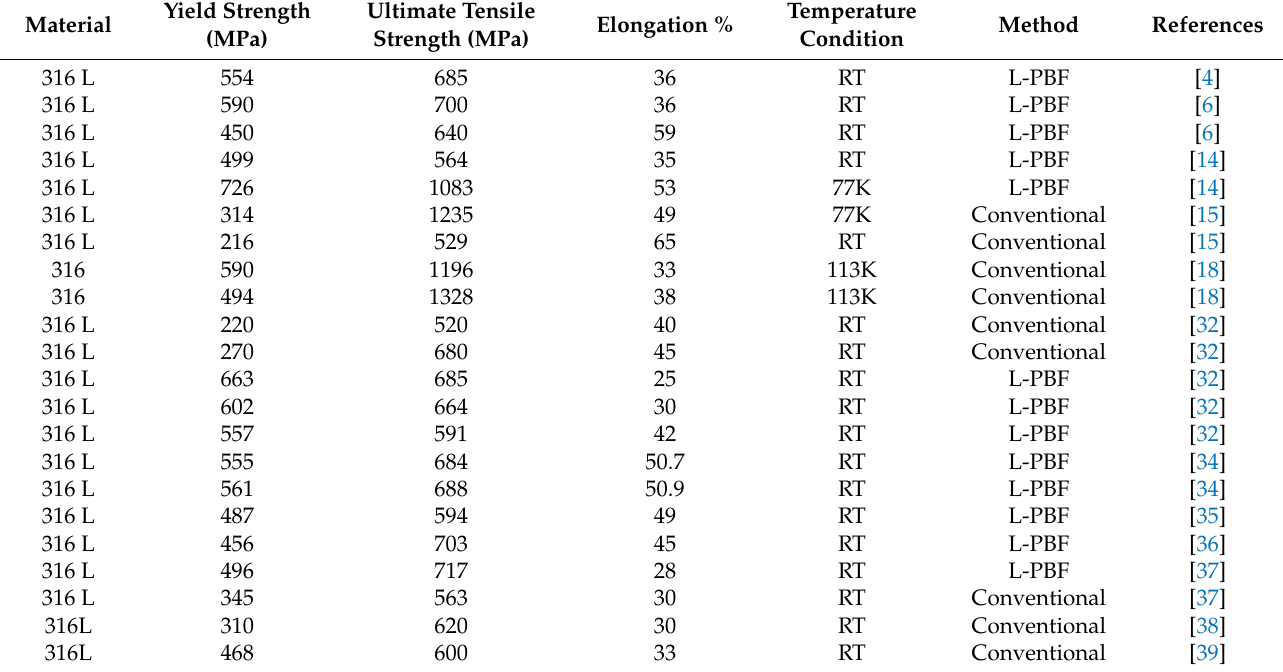
Table 4. A summary of the yield strength, ultimate tensile strength, and elongation for various 316 alloys conventionally built and L-PBF at room and cryogenic temperature from the